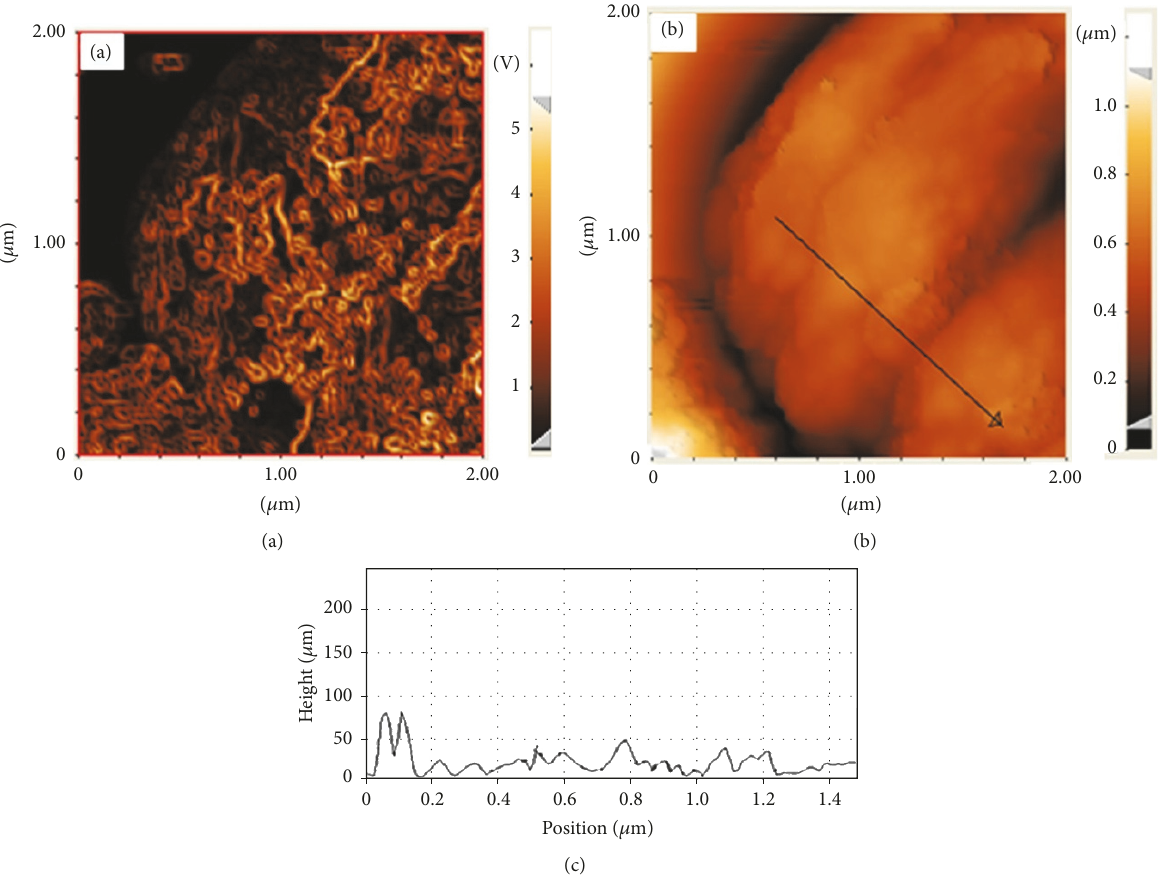
Figure 10: AFM images of rGO-Zn coating produced by pulse-potential electrodeposition approach, (a) edge detection filter mode and (b, c) topography and height profile scanned across the profile line.